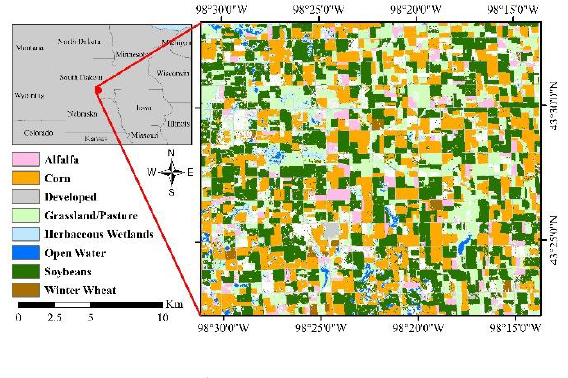
Figure 1 . Study Area